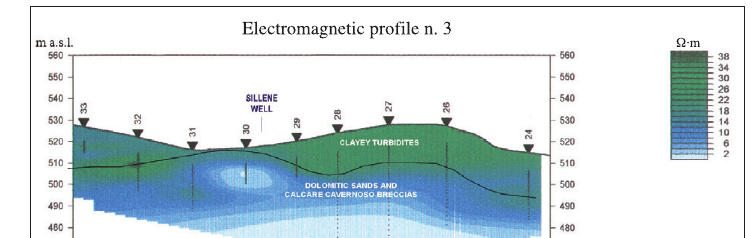
Fig. 6. Profile n. 2.